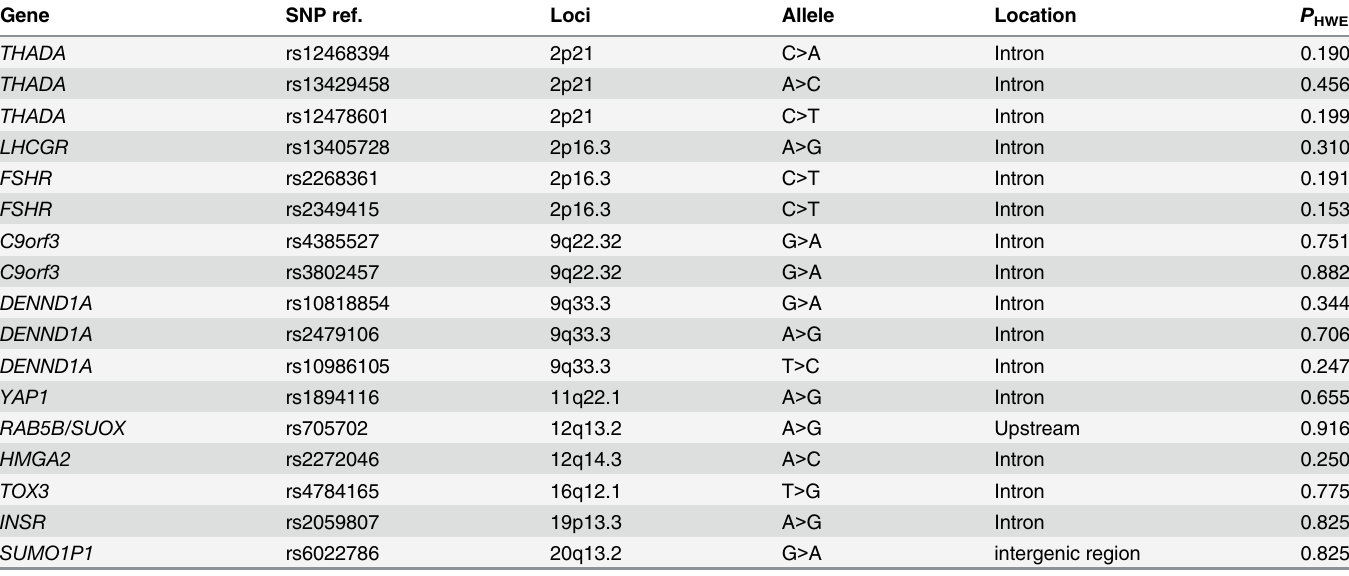
Table 2. Information of the 17 SNPs detected. Gene SNP